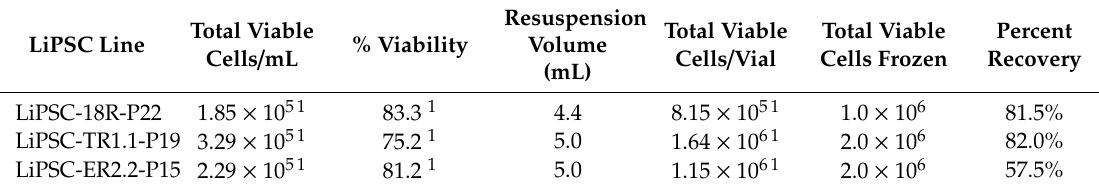
Table 1. Viability and recovery of the LiPSC (Lonza induced pluripotent stem cells) lines after long-term